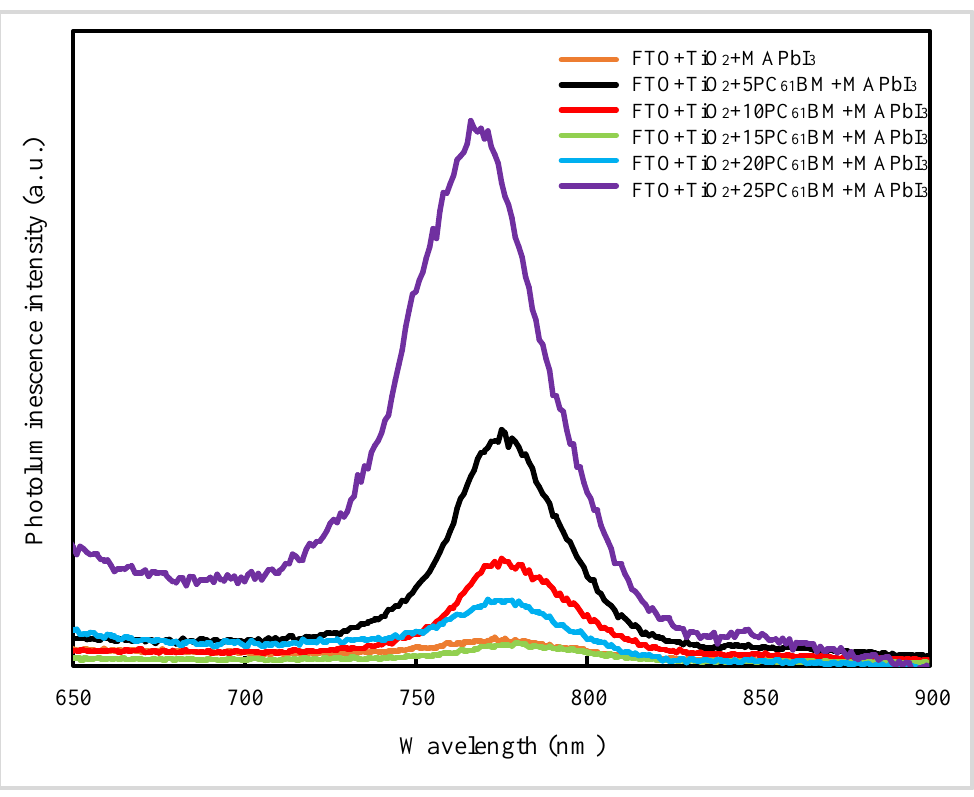
Figure 7. Photoluminescence spectra of perovskite films deposited on PC 61 BM of different concentration. The number 5, 10, 15, 20, 25 represent different concentration of PC 61 BM.